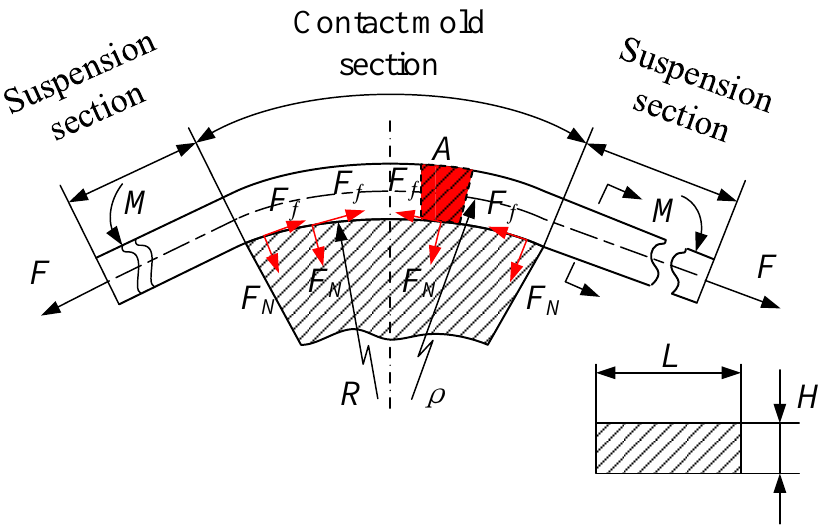
Figure 1. Force analysis of the stretch and bend synchronous loading process. Due to the axial symmetry of the contact mold segment, 1/2 was taken for analysis. The contact mold segment was divided into innumerable micro-units. The force analysis of the micro-unit at section A point shown in Figure 1 was taken as shown in Figure 2. The arc angle corresponding to the micro-unit is ∆ θ . The tension on the left and right sides of the micro-unit are F i + 1 and F i , respectively. The positive pressure of the micro-unit on the arc surface of the mold is F N . According to the decomposition of forces and Coulomb’s i law of friction, the positive pressure F N and the frictional force F f on the surface of the i i micro-unit are calculated as: